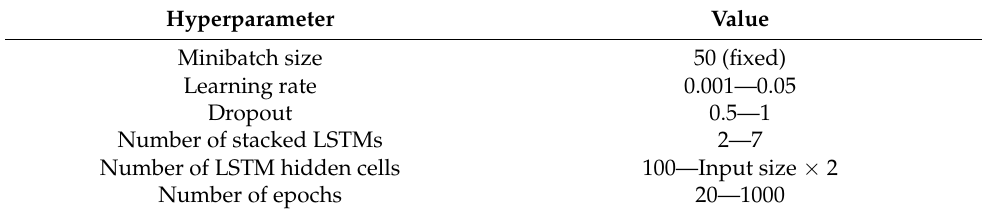
Table 3. Search ranges for hyperparameter optimization.